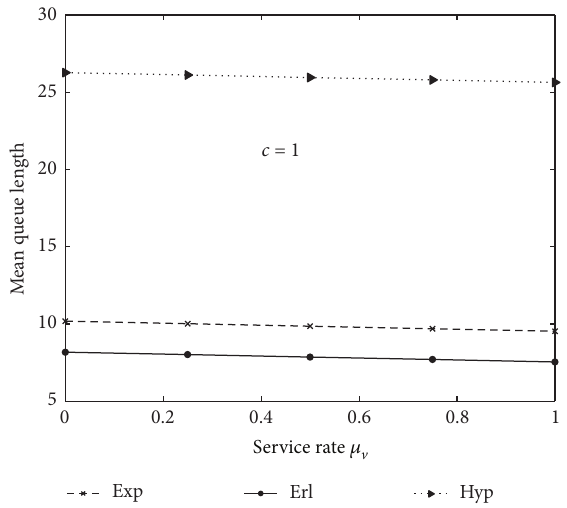
Figure 2: Mean queue length versus vacation-service rate with 𝜌 = 0.5 , 𝜉 = 0.1 , 𝜃 = 0.1 , and 𝑐 = 3 .